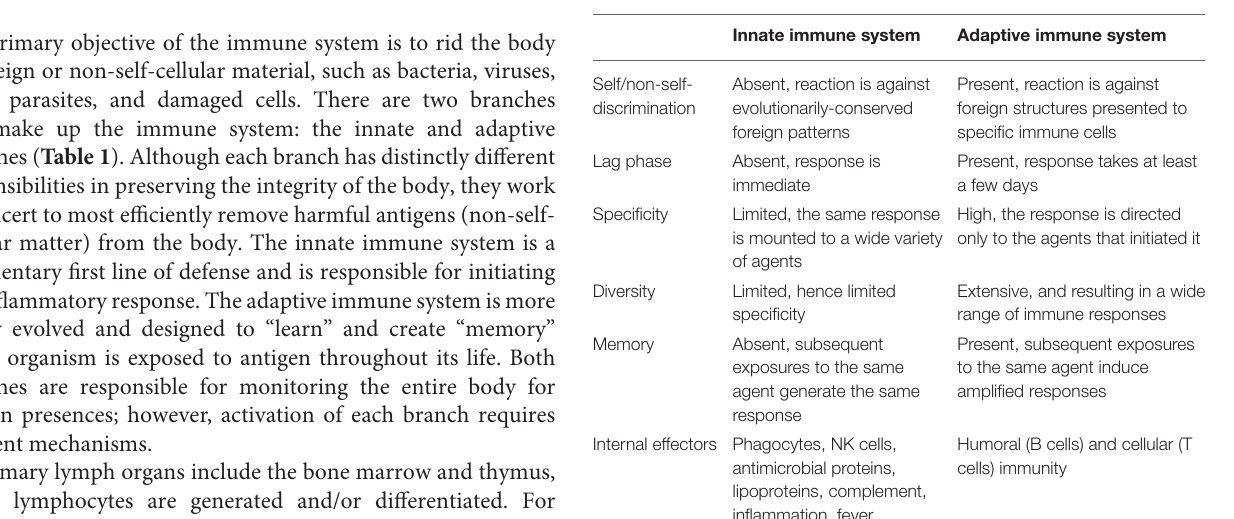
TABLE 1 | Characteristic functions of the immune system by